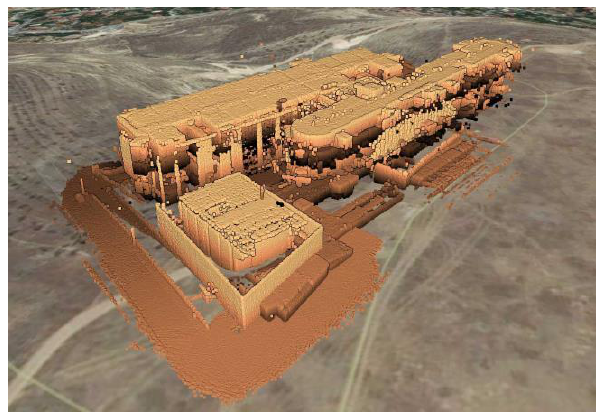
Figure 7. SBIF LIDAR Point Cloud.